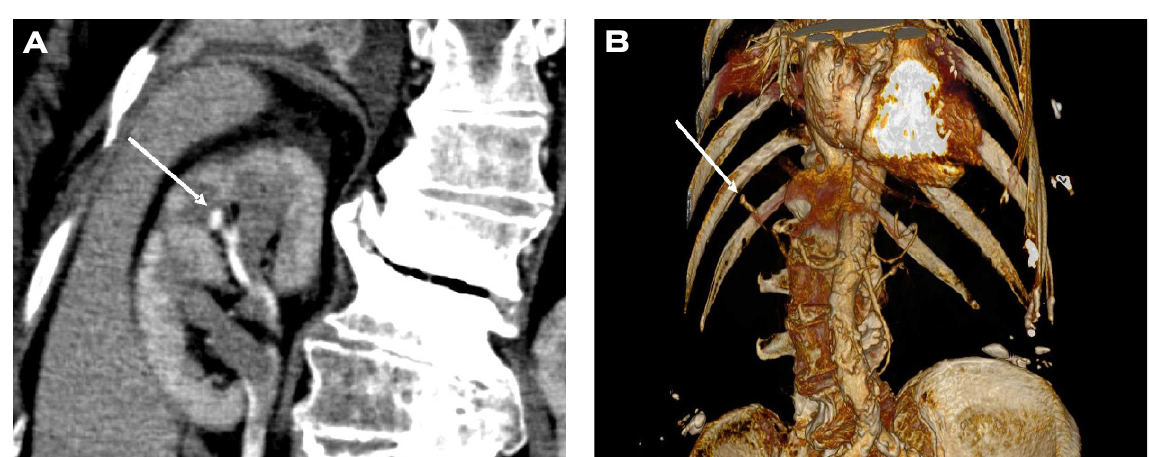
Figure 1. A. Angio-CT scan: ruptured branch of the renal upper pole artery and direct contrast extravasation into the upper calyx of the right kidney (white arrow). B. Three-dimensional rendering of angio-CT: early arterial phase, contrast visible in upper renal calyx (white arrow).